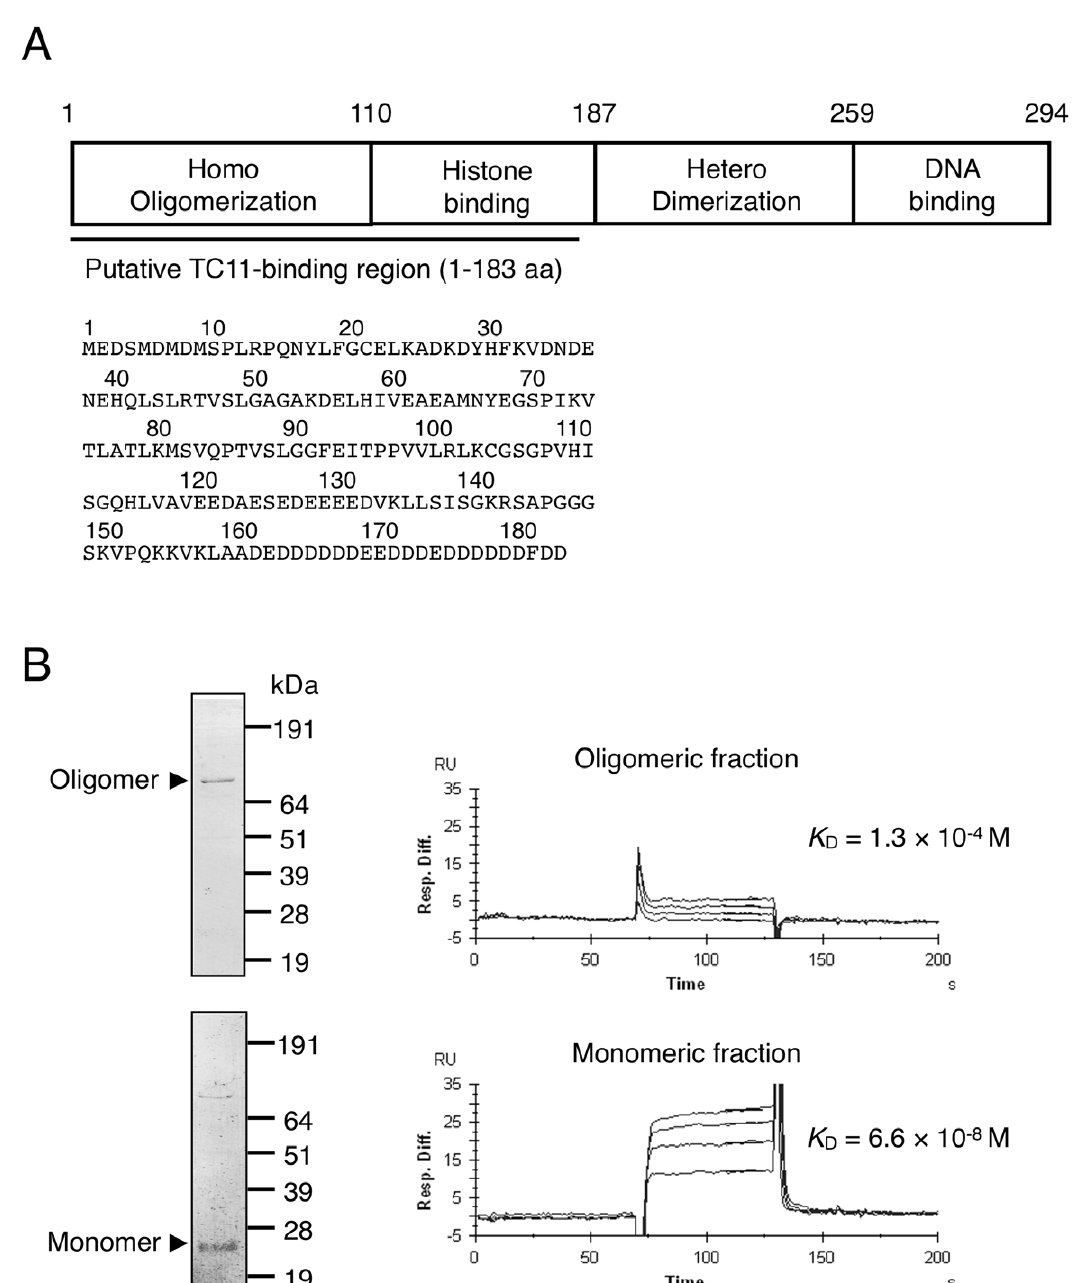
Figure 5. Monomeric NPM interacts with TC11. (A) The domain structure of NPM and the amino acid sequence predicted by NPM clone 1–183, which was identified as encoding a binding protein of TC11 by mRNA display using a cDNA library prepared from KMS34 cells. The underlined part indicates the region (1–183 a. a.) identified by mRNA display selection. The sequence indicated by the solid line corresponds to that encoded by the ORF of NPM cDNA. (B) Recombinant NPM 1–183 was expressed in E. coli and fractionated into monomeric and oligomeric forms. Then, each fraction was subjected to 10% SDS-PAGE followed by CBB staining (left). A representative biosensorgram of NPM binding on SA sensor chips with immobilized biotinylated-TC11 is shown. The K D values were determined (right). HeLa cells with TC11, most interphase cells had multiple nuclei, NPM Knockdown Induced Multipolar Spindles and while control cells had a single nucleus (Figure 6C). The former Apoptosis cells may occur as a result of division of cells with multipolar To investigate whether NPM is related to the multipolarity of spindles. It was recently reported that cells with multiple nuclei mitotic cells, we performed a NPM knockdown experiment. HeLa have poor viability and undergo apoptosis [28]. Therefore, we cells were transfected with siRNA for NPM and after 48 h, NPM considered that TC11-induced apoptosis would occur through this protein levels were confirmed to be repressed to , 20% (Figure 7A). mechanism.